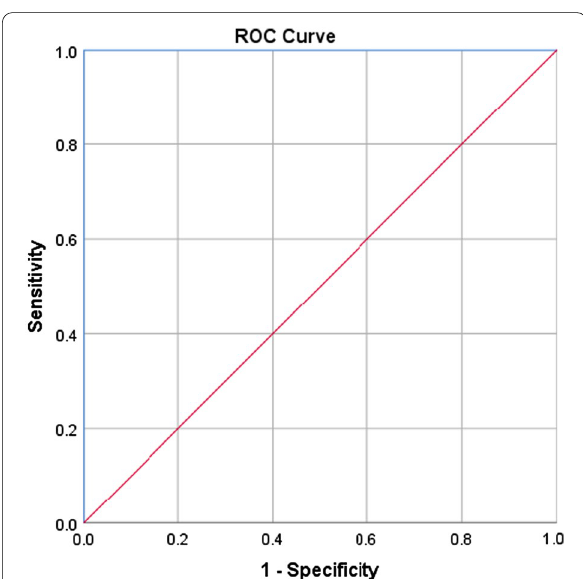
Fig. 2 ROC curve showing specificity and sensitivity of median nerve